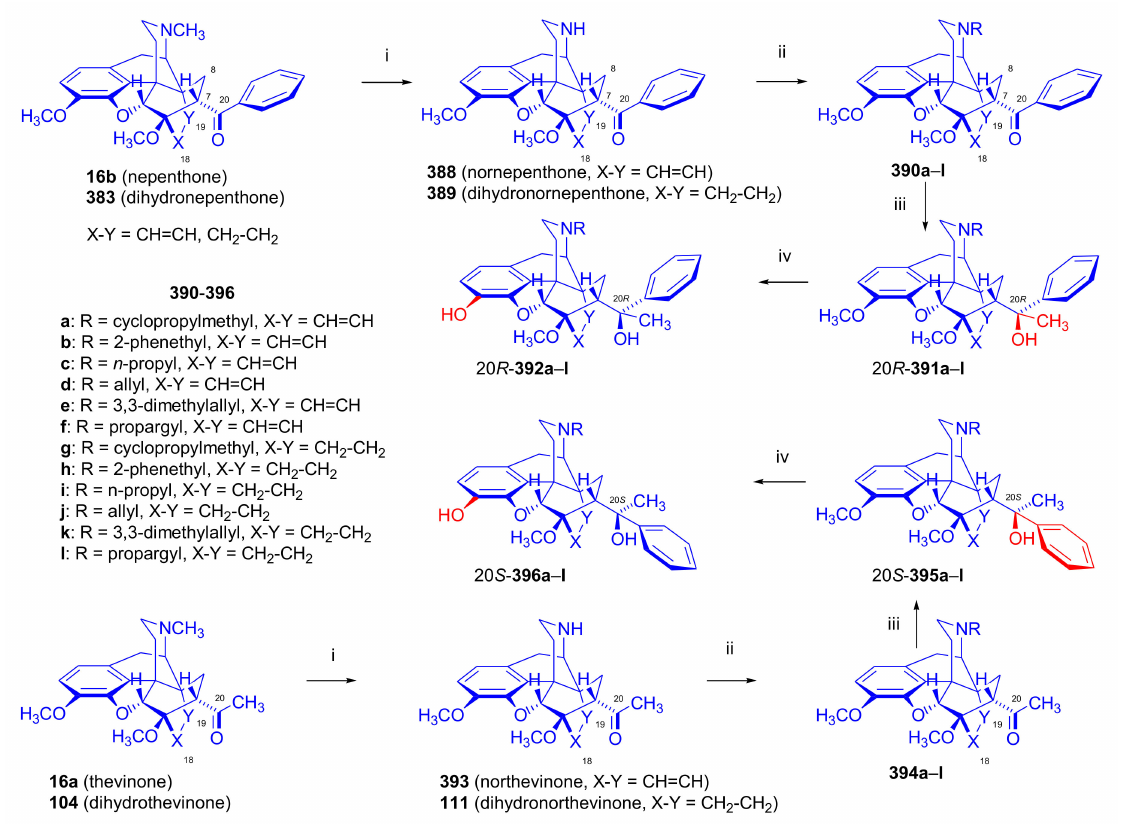
Figure 100. Synthesis of 20 R - and 20 S -phenyl-6-14-ethenomorphinan derivatives. Reagents